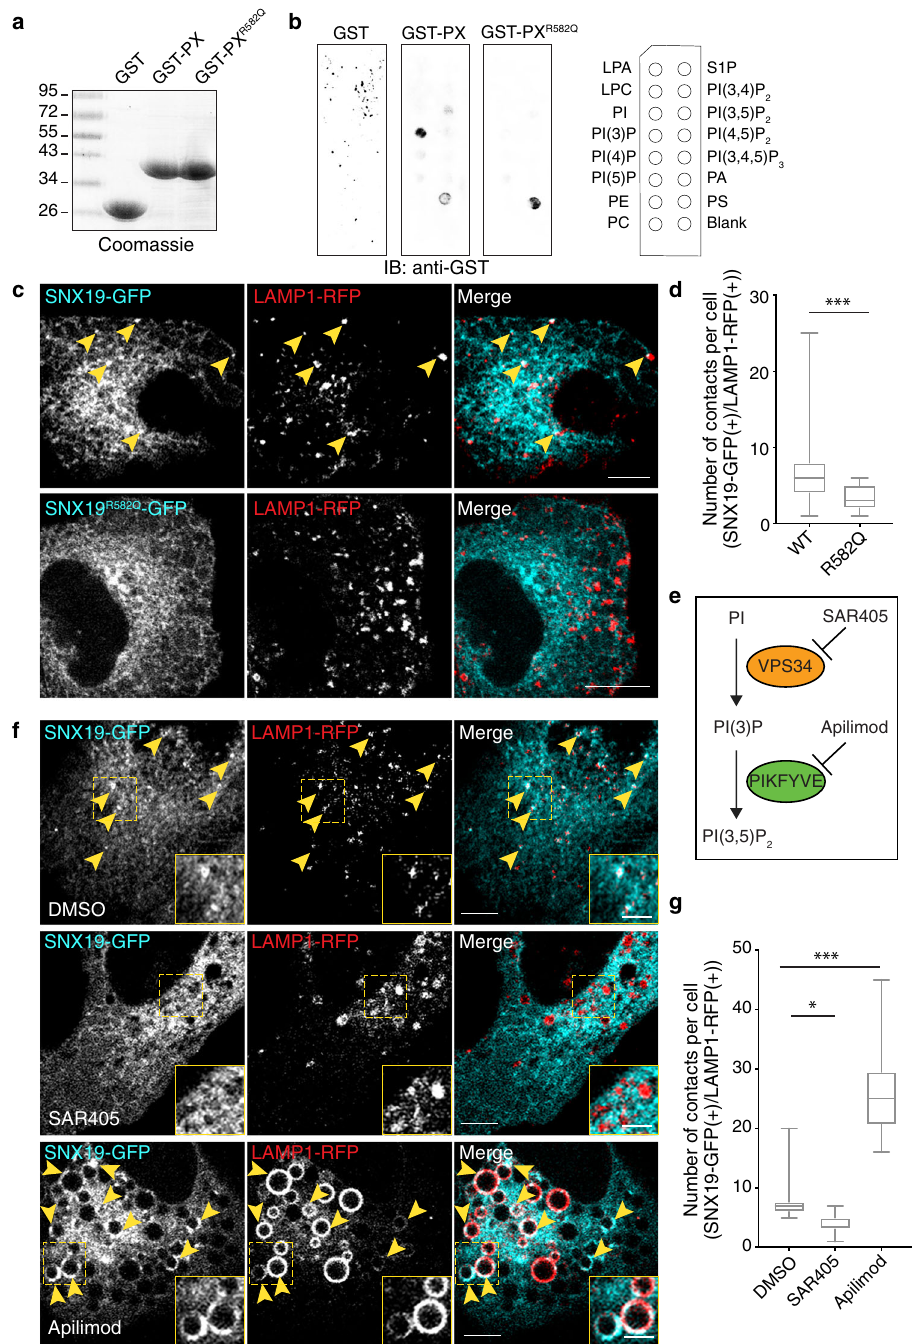
Fig. 2 SNX19 contacts endolysosomes via interaction of its PX domain with PI(3)P. a Puri fi ed GST, GST-PX domain from SNX19 and GST-PX R582Q containing a point mutation in the PX domain of SNX19, were subjected to SDS-PAGE, and the gel was stained with Coomassie blue. The positions of molecular mass markers (in kDa) are indicated on the left. Experiment was repeated two independent times. b PIP Strips were incubated with puri fi ed GST, GST-PX, or GST-PX R582Q , and immunoblotted for GST. A scheme of spotted lipids on the strips is shown at right. c U-2 OS cells were co-transfected with expression plasmids encoding either SNX19-GFP or SNX19 R582Q -GFP together with LAMP1-RFP, and imaged live by confocal microscopy. Arrowheads in the upper row point to representative SNX19-EL contacts. d Quanti fi cation of SNX19-GFP – LAMP1-RFP contacts from c . Box and whisker plots (drawn as indicated for Fig. 1f) are from 25 to 40 cells per condition, across n = 3 experiments. Mann – Whitney test was applied to determine signi fi cance, *** two-tailed p -value<0.001. e Scheme showing lipid kinase inhibitors and their targets. f U-2 OS cells were co-transfected with plasmids encoding SNX19-GFP and LAMP1-RFP, treated with either DMSO control (top row), 1 μ M SAR405 (middle row), or 200nM apilimod (bottom row) for 2h, and imaged live by confocal microscopy. Arrowheads point to representative SNX19-GFP – LAMP1-RFP contacts. g Quanti fi cation of contacts observed in f . Box and whisker plots represent data from three independent experiments, where 10 – 20 cells were quanti fi ed per condition, per experiment. Signi fi cance was analyzed by Kruskal – Wallis one-way ANOVA; * p = 0.0175, *** p <0.001. For plots in d and g , the box extends from 25th to 75th percentiles, the horizontal line represents the median, and the whiskers represent the minimum and maximum values. Source data are provided as a Source Data fi le. Scale bars: 10 μ m in c and f 5 μ m